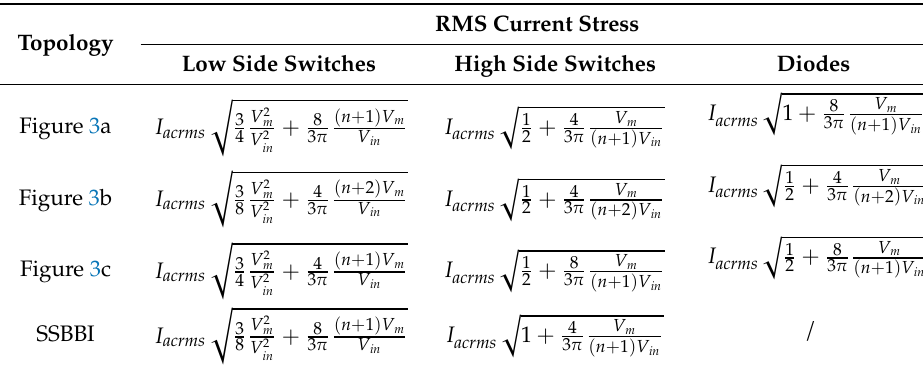
Table 8. Comparison of the RMS current stress.